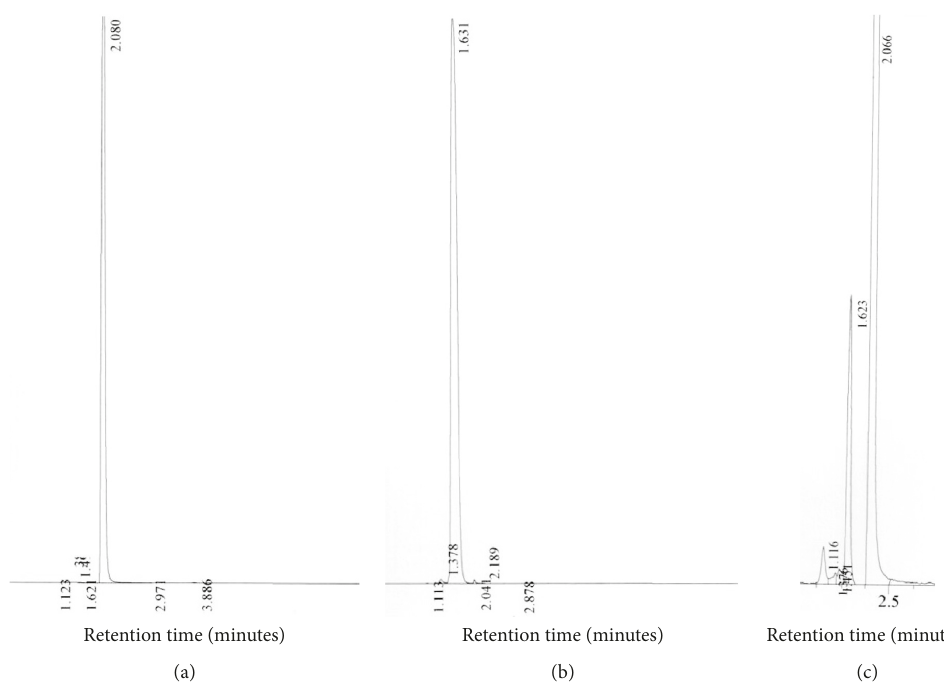
Figure 1: HPLC chromatograms of vinylbenzoic acid (a), 4-carboxybenzaldehyde (b), and the reaction mixture obtained by incubating vinylbenzoic acid and methionine sulfoxide with a singlet oxygen-generating myeloperoxidase system (c), showing some conversion of vinylbenzoic acid to 4-carboxybenzaldehyde. Incubating methionine with vinylbenzoic acid and the myeloperoxidase system gave a similar